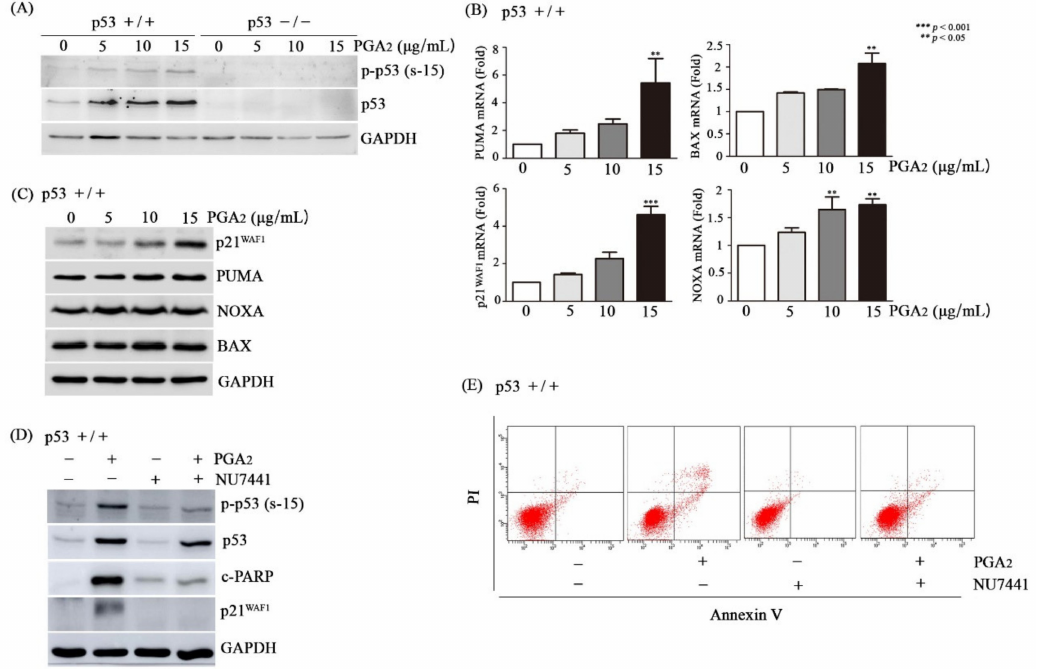
Figure 2. Activation of p53 by DNA-PK in PGA 2 -treated HCT116 cells. ( A ) HCT116 cells (p53 +/+ ) and HCT116 p53 null cells (p53 - / -) were treated with indicated concentrations of PGA 2 . After 12 h, WCLs were subjected to immunoblot analysis against phospho-p53 [Ser-15, p-p53 (s-15)], p53, and GAPDH as an internal reference protein. ( B ) Total cellular RNA of HCT116 cells treated with indicated concentrations of PGA 2 for 12 h were subjected to qPCR against indicated genes using GADPH as an internal reference gene for normalization. ( C ) HCT116 cells treated the same as described in ( B ) were subjected to immunoblot analysis against indicated proteins using GADPH as an internal reference protein. ( D ) HCT116 cells were treated with vehicle or NU7441, an inhibitor of DNA-PK, for 1 h and were incubated in the absence or presence of PGA 2 (15 µ g / mL) for another 18 h. Cells were then subjected to immunoblot analysis against phospho-p53 (Ser-15), p53, p21 WAF1 , cleaved PARP1 (c-PARP1), and cleaved caspase-3 (c-Caspase-3) using GAPDH as an internal reference protein. ( E ) HCT116 cells treated the same as described in ( D ) were subjected to annexin V assay. The result is representative of three independent